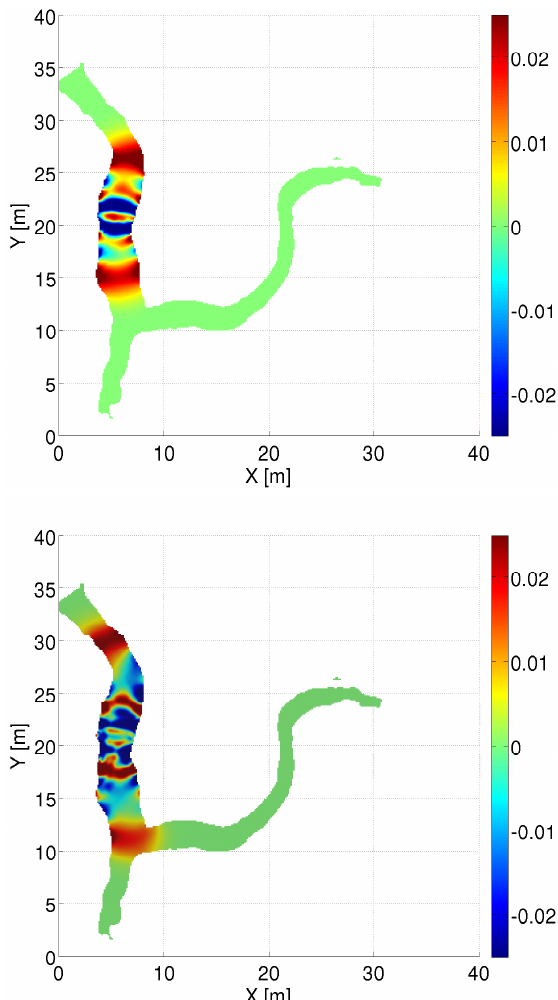
Figure 4. Initial surface elevations after wave gauge input data along the B-bridge have been tapered off. Upper panel: surface ele- vation after t = 5.07s (B4 signal tapered between 4 and 5s). Lower panel: surface elevation after t = 7.1s (B4 signal tapered between 6 and